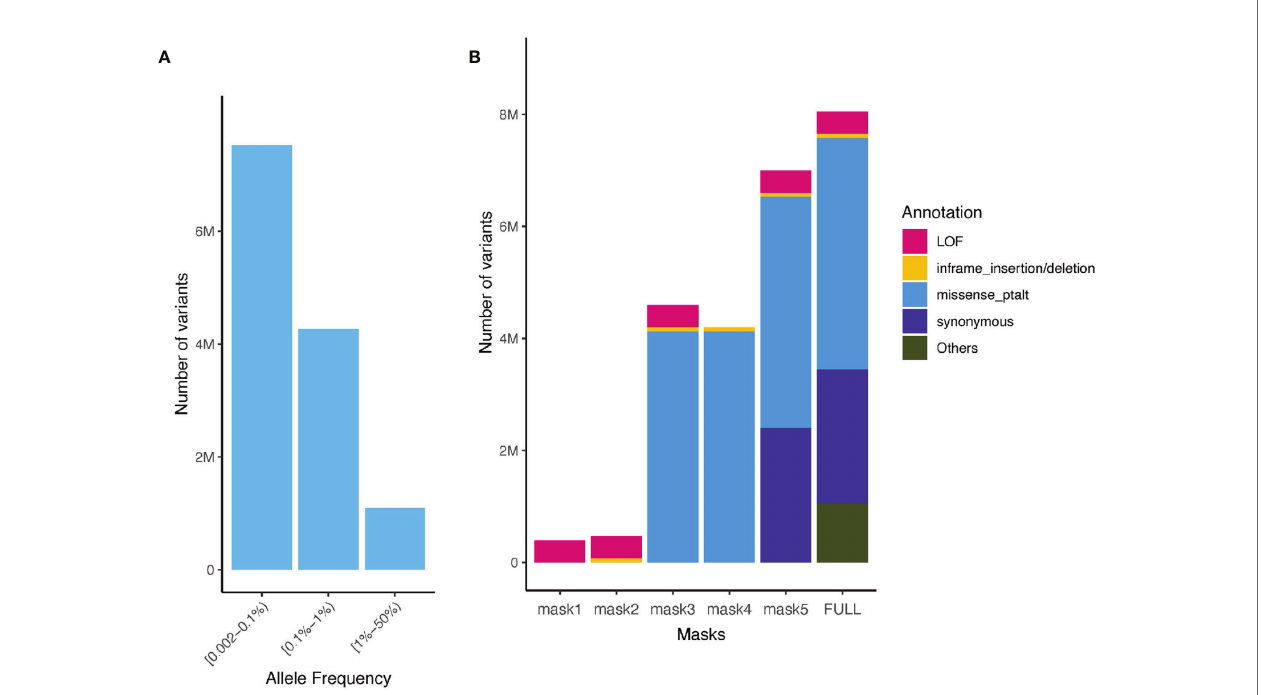
FIGURE 2 | Allele frequency spectrum of imputed variants and number of aggregated sequenced variants captured in the UK Biobank and the TOPMed. (A) Minor allele frequency spectrum of imputed variants present in the UK Biobank (rare variants imputation INFO ≥ 0.8, common Hapmap3 variants imputation INFO ≥ 0.3) and TOPMed; (B) Number of variants for different functional class of variants and masks (aggregation model) in the UK Biobank WES ultra-rare variants (MAF <